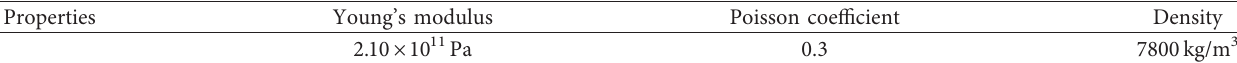
Figure 9: Drawings of the designed spring. Table 5: Material properties of the spring.